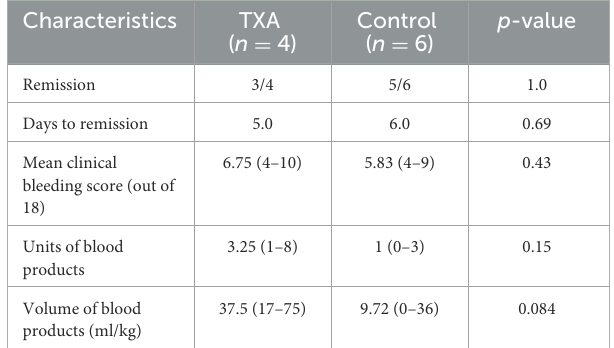
TABLE 2 Outcomes for dogs with immune thrombocytopenia in the tranexamic acid (TXA) and the control